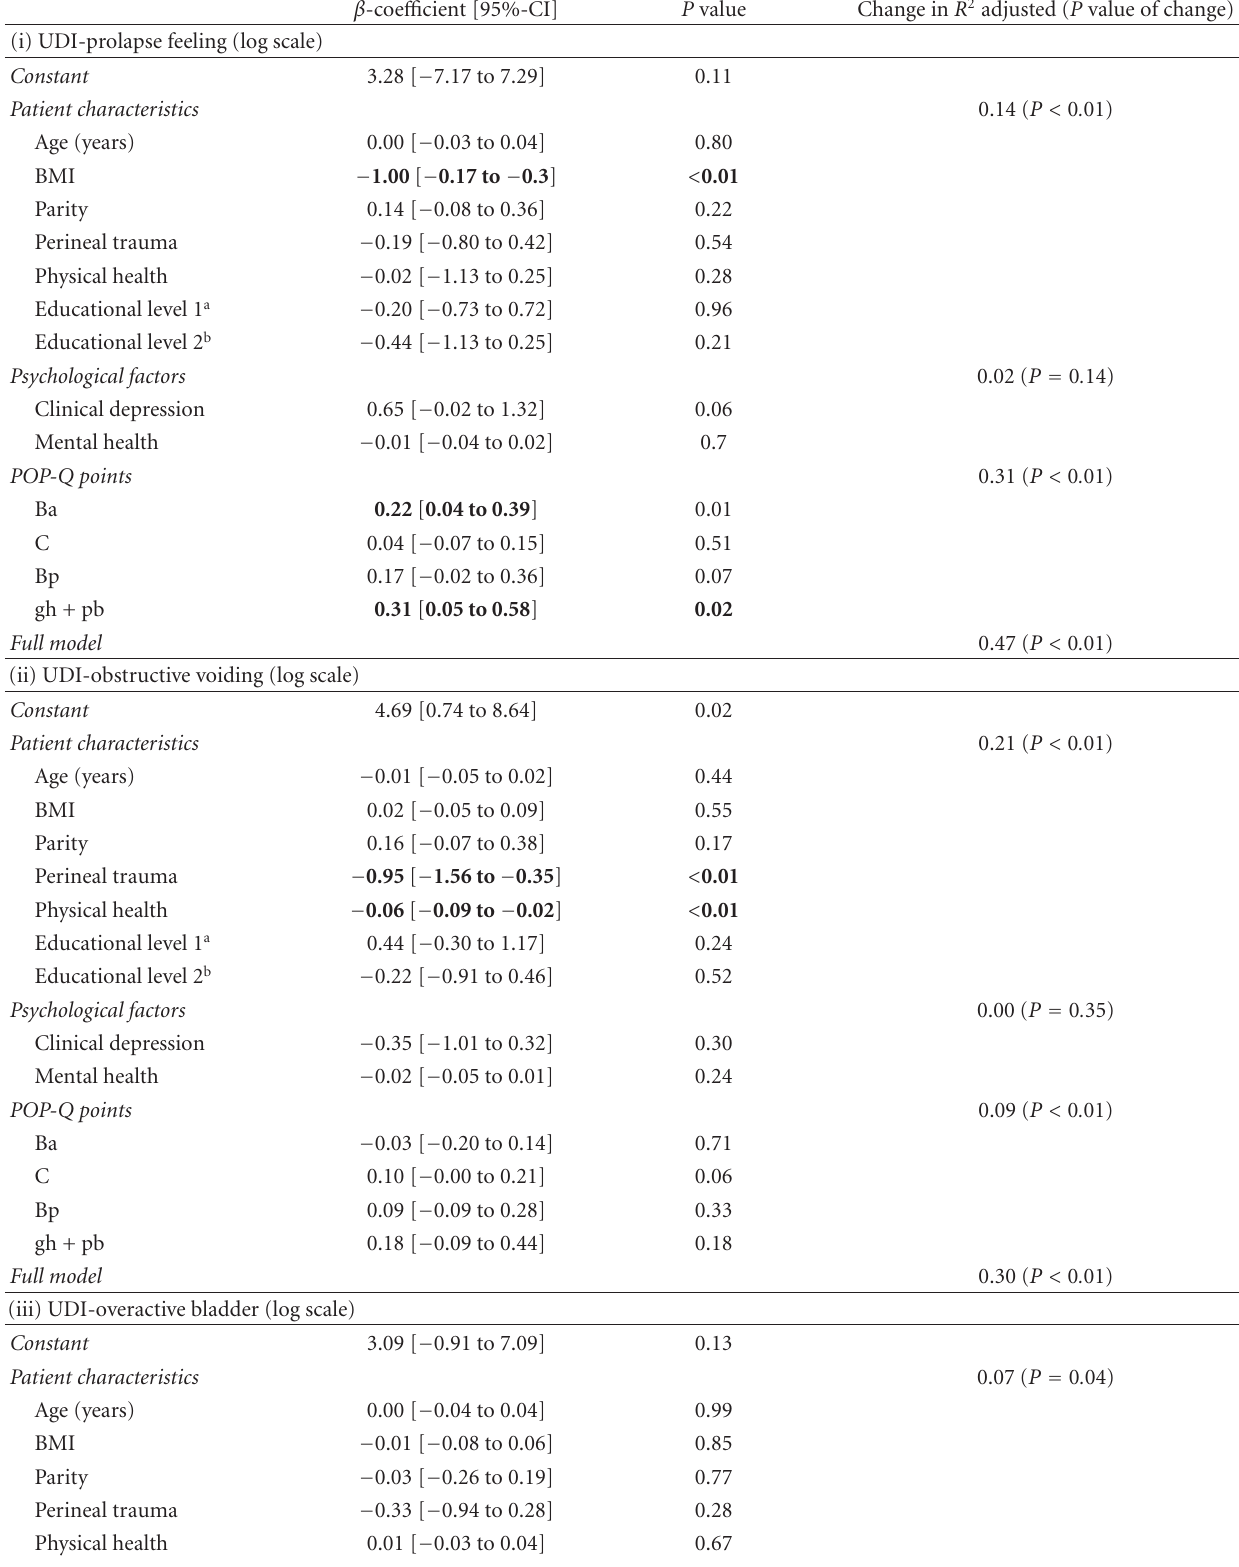
Table 2: Multiple linear regression analysis showing the relationship between patient’s characteristics, psychological characteristics and anatomical defects at the one hand and pelvic floor symptoms (log scale) at the other hand. β -coe ffi cient [95%-CI] P value Change in R 2 adjusted ( P value of